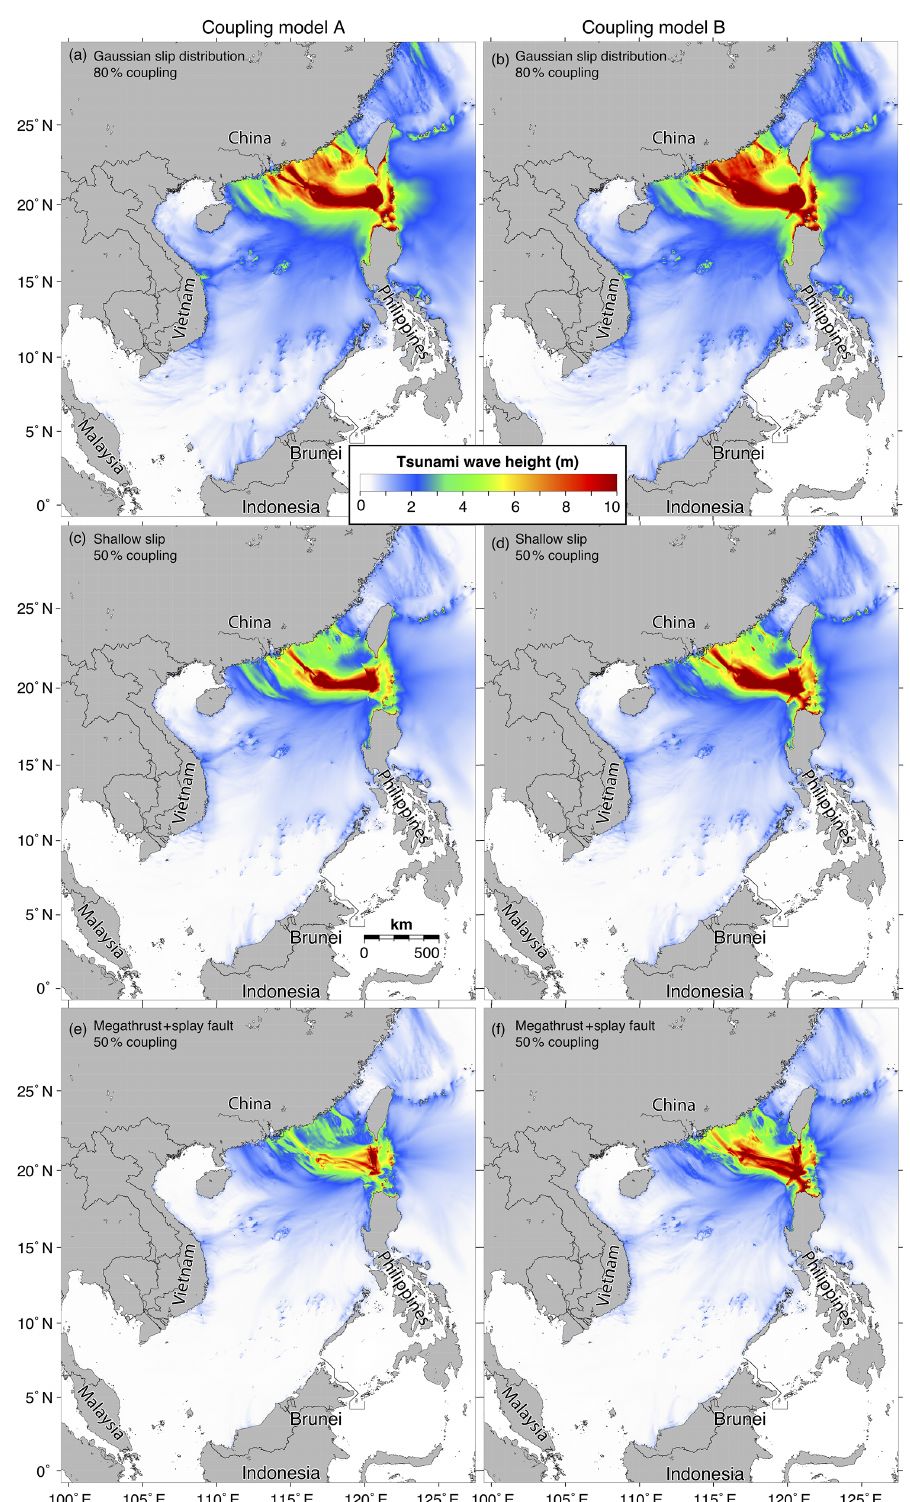
Figure 8. Maximum tsunami wave heights from different rupture characteristics in zone 3 with hybrid coupling models. Panels (a, c, e) show the maximum tsunami wave heights based on coupling model A (Hsu et al., 2016). Panels (b, d, f) show the same maximum tsunami wave heights but with slip models based on coupling model B (Hsu et al.,